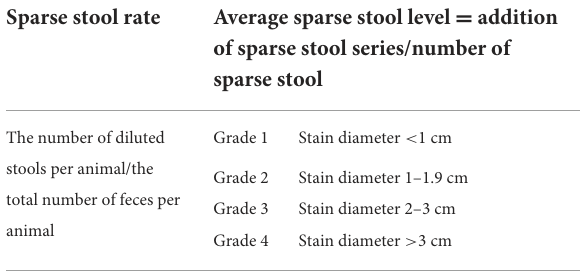
TABLE 2 Criteria of diarrhea